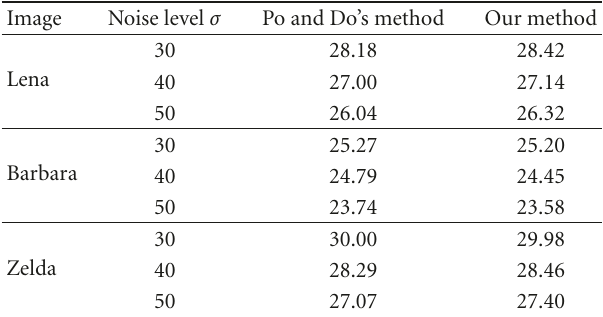
Table 2: Denoising e ff ects comparison for di ff erent images on various noise levels (PSNR in